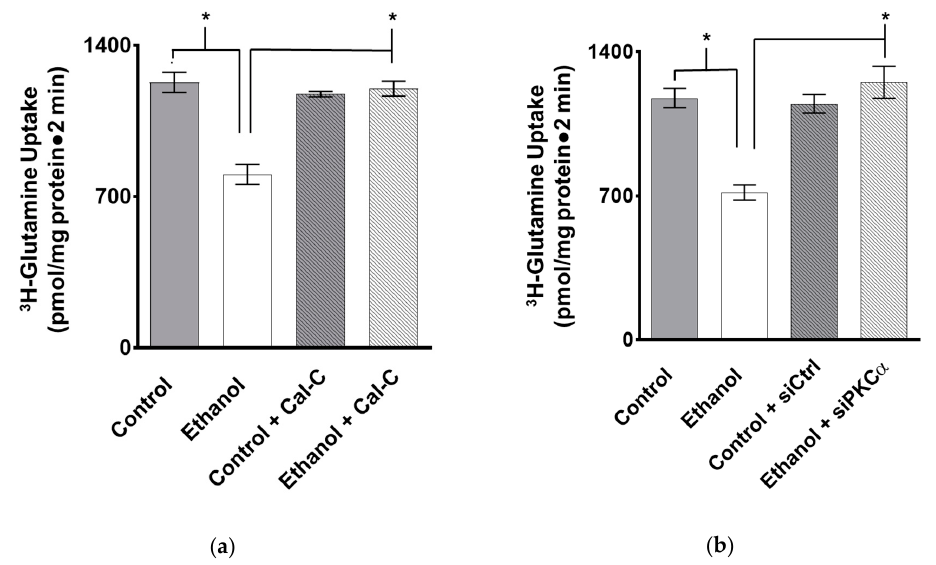
(Figure 10b; p > 0.05, n = 3) which indicated that PKC α is likely important in the ethanol-mediated inhibition of B0AT1.